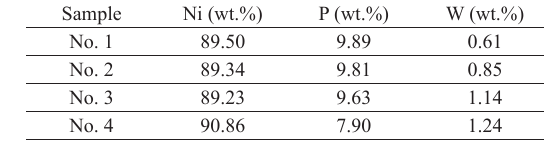
Table 4. The results of energy spectrum analysis of Ni-W-P coatings.